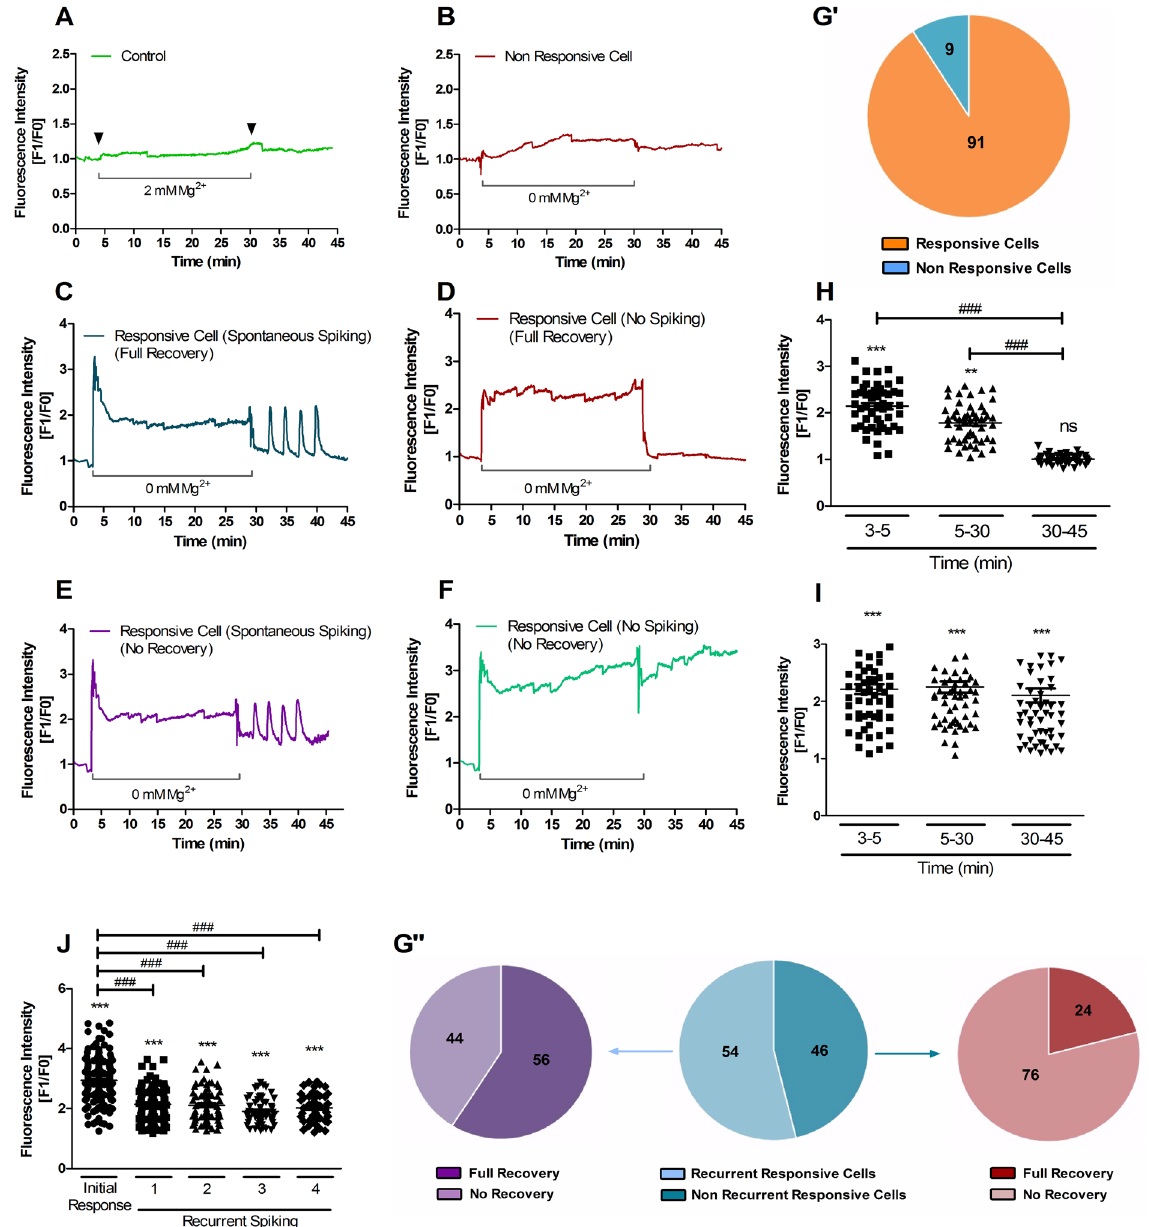
Figure 3. Characterization of [Ca 2+ ] i transients induced by incubation of hippocampal neurons in [Mg 2+ ] 0 medium for 30 min. ( A – F ) Cultured hippocampal neurons (15 DIV) were analysed by single cell calcium imaging using the Fluo-4 fluorescent Ca 2+ indicator, with Spinning Disk microscopy. The cells were initially incubated in control salt solution containing 2 mM Mg 2+ for 3 min to determine the baseline level of fluorescence. After 3 min, the solution was replaced with [Mg 2+ ] 0 medium for the indicated period. In the experiments described in panel ( A ), where indicated by the arrows the Mg 2+ -containing buffer was replaced by a solution with the same composition. At t = 30 min, the buffer was replaced by control salt solution for an additional period of 15 min. Fluo-4 fluorescence was recorded for the duration of the experiment. For each time point the results are represented as the normalized intensity of Fluo-4 fluorescence (Fluorescence for a given time point divided by the baseline fluorescence). The analyses represent the different types of response to the incubation in [Mg 2+ ] 0 medium. ( G ′ , G ″ ) Pie chart representation of the diversity of responses to incubation in [Mg 2+ ] 0 medium as a percentage of the total number of cells with the indicated pattern of response. ( H , I) A comparative analysis of the [Ca 2+ ] i response profile was made between the cells that showed a recovery to basal calcium levels ( C and D; H) and the cells that showed a partial recovery [e.g. E ] or no recovery [e.g. ( F) ] . In the latter case the results are plotted together in panel ( I) . ( J) Calcium oscillations were comparatively analysed to determine the differences between the initial response to the incubation in [Mg 2+ ] 0 medium and the spontaneous transients that developed after the stimulus (in control salt solution). Results are the mean ± SEM of at least three independent experiments performed in distinct preparations. *** p < 0.001, ### p < 0.001; Repeated measures ANOVA followed by Dunnett’s (*) and/or Bonferroni ( # ) test. ns, not significantly